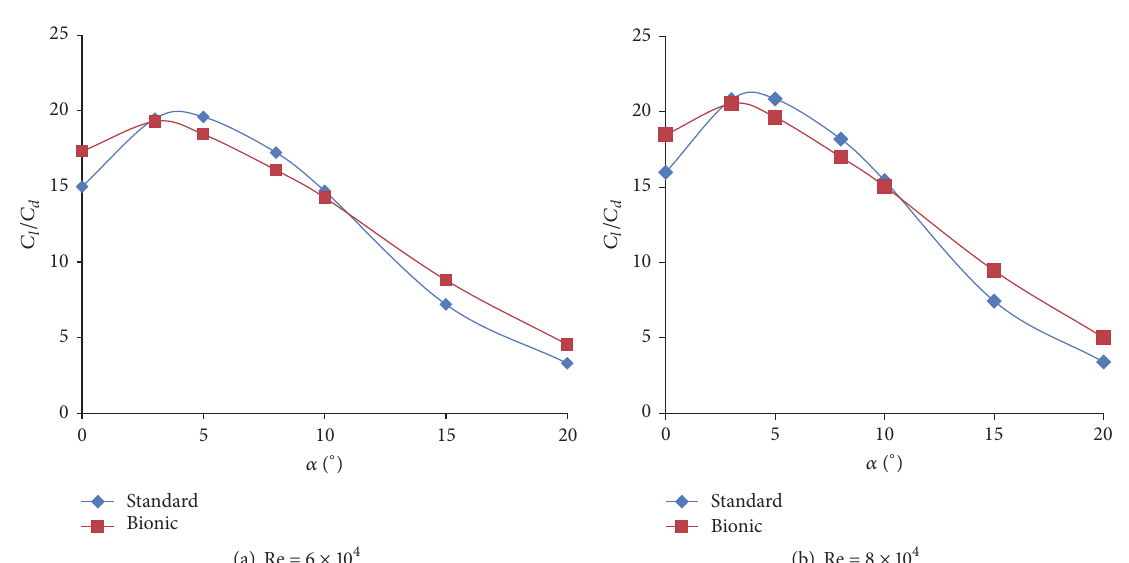
Figure 16: Lift-to-drag ratio ( 𝐶 𝑙 / 𝐶 𝑑 ) curves of the airfoils at different AOA. “Standard” is the lift-to-drag ratio of the standard airfoil; “Bionic” is the lift-to-drag ratio of the bionic airfoil.